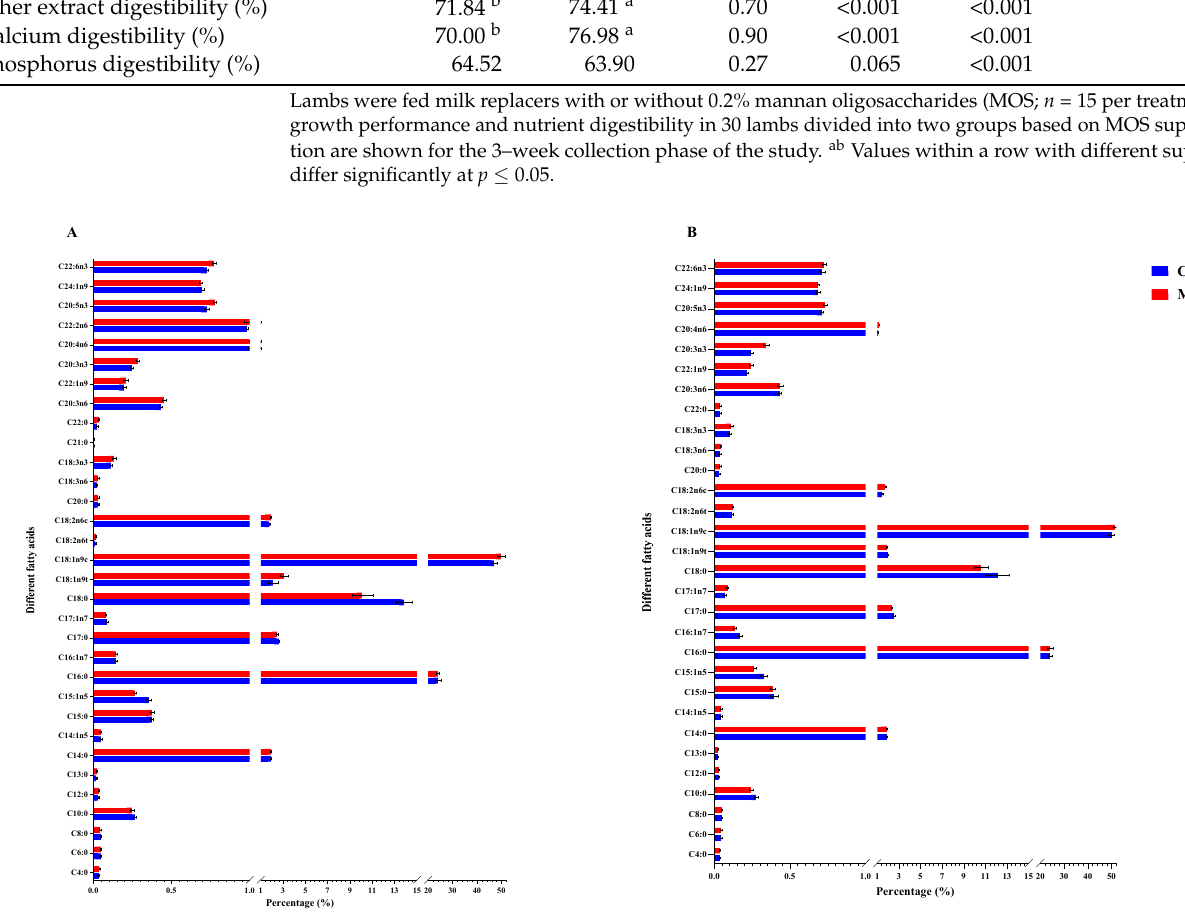
Figure 2. Fatty acids composition and proportion in muscle and adipose tissue of Hu lambs treated with either control or mannan oligosaccharides milk replacer. ( A ) longissimus dorsi muscle; ( B ) ab- dominal adipose tissue. Lambs were fed milk replacers with or without 0.2% mannan oligosaccha- rides (MOS; n = 8 per treatment). The individual fatty acid percentages of total fatty acid methyl esters quantified in 16 lambs divided into two groups based on MOS supplementation are shown for the 3–week collection phase of the study.